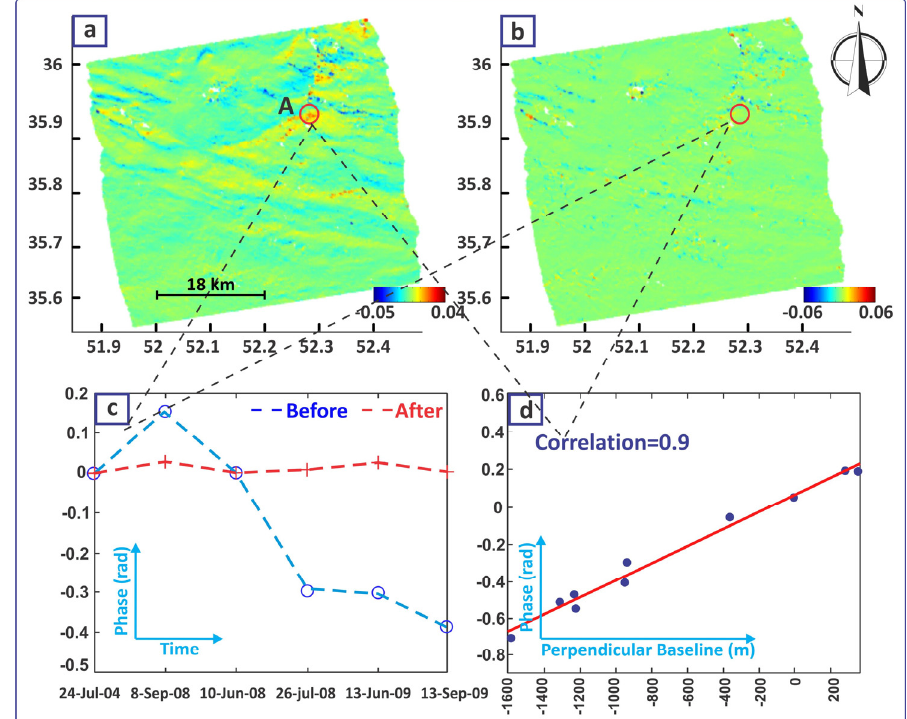
Figure 19. Phase difference map calculated by differencing the phase values between pixels connected by Delaunay edges (a) before and (b) after correction for a pair of ALOS ascending dataset: 24 July 2007 and 13 June 2009; the colorbar is in radian. ( c ) Time series plot for a specific location (point A) before and after applying topographic correction. ( d ) The correlation plot between phase and perpendicular point for point